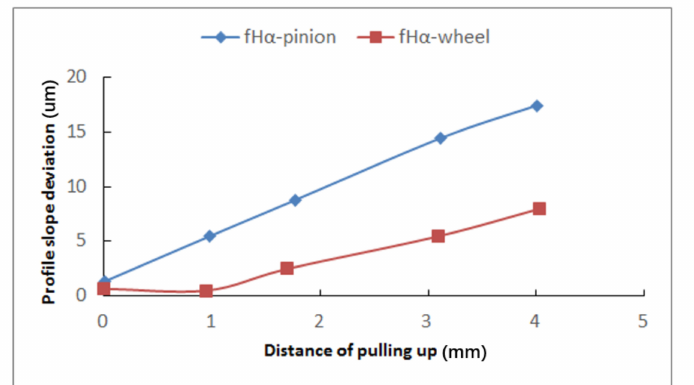
Figure 9. Relationship between pulling up and profile slope deviation for pinion and wheel.